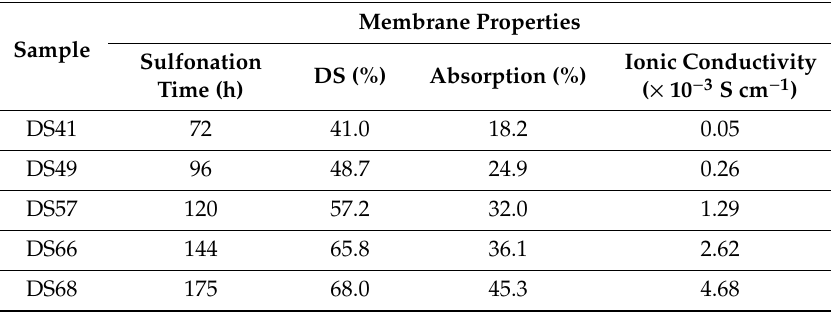
Table 1. E ff ects of sulfonation time on water absorption, ionic conductivity, and degree of sulfonation for the sPEEK membrane samples.